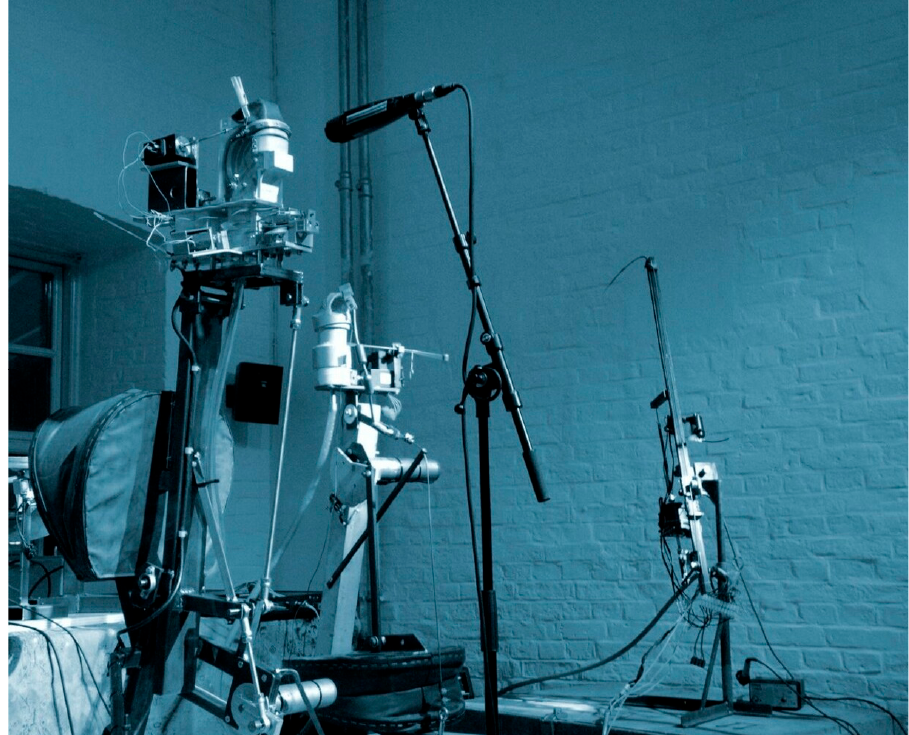
Figure 2. The Sirens performing at a public tryout in Hamburg in 2008 in preparation for the band’s last gig in Krems (Austria). From left to right: robot voice Aciilyzer, another robot voice, and robot bass Peisinoe. Courtesy of Nicolas Baginsky.